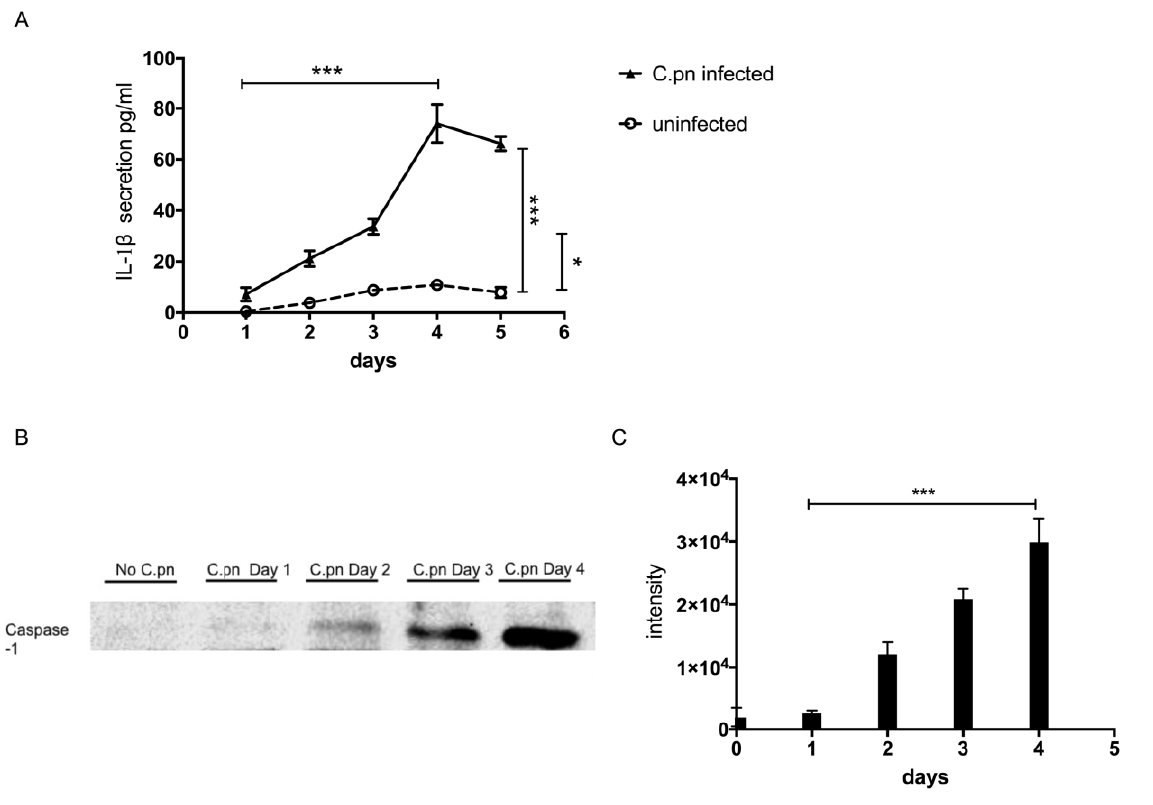
FIGURE 4: C. pneumoniae infection activates caspase-1 and IL-1 β release. Equal numbers of GECs were infected with C. pneumoniae and cultured in equal volumes of medium for five days in (A) and four days in (B, C) at a MOI of 5. At 0, 1, 2, 3, 4 and 5 days post-infection, supernatants were collected and analyzed for the presence of mature IL-1 β or activated caspase-1 protein. (A) IL-1 β ELISA. Assays were performed in triplicates, n = 3 independent experiments. (B) Western blot representative gel and (C) quantification of active caspase-1 proteins. Three independent experiments were performed. For panels A and C: error bars represent ± SD; 2- sided, paired Student’s t test, *** P <